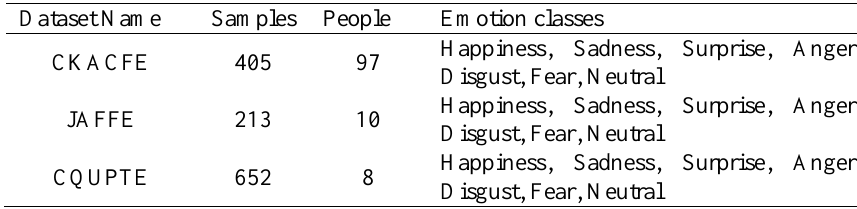
Table 1 Three facial emotional